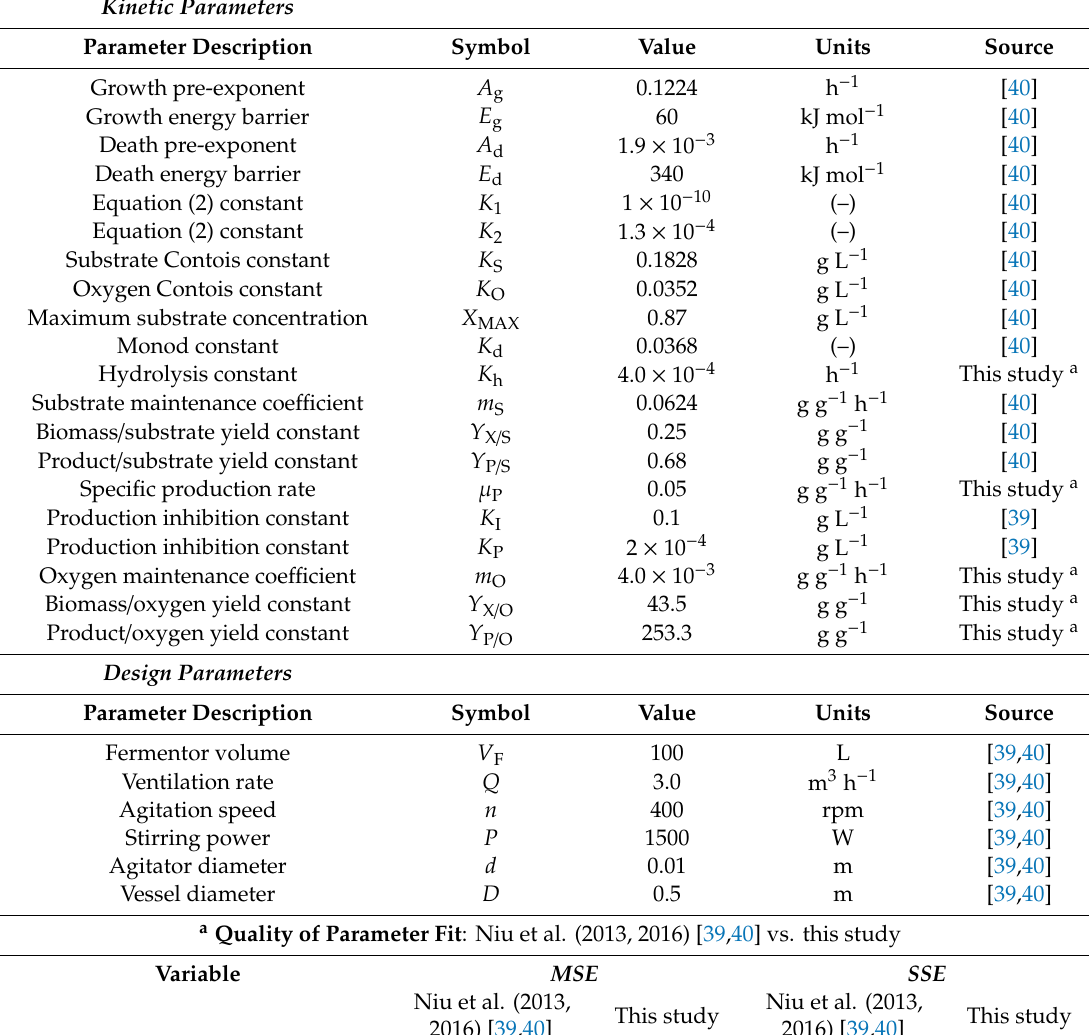
Table 3. Kinetic (published and regressed in this study) and fermentor design